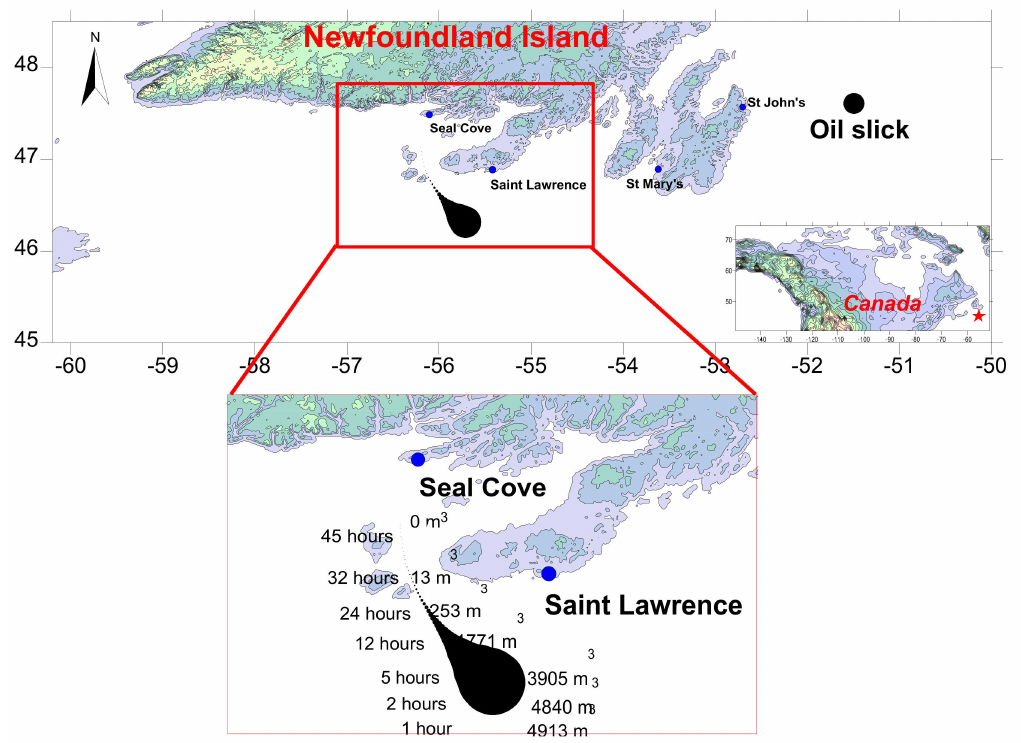
Figure 9. Spill trajectory and volume change based on optimal skimmer